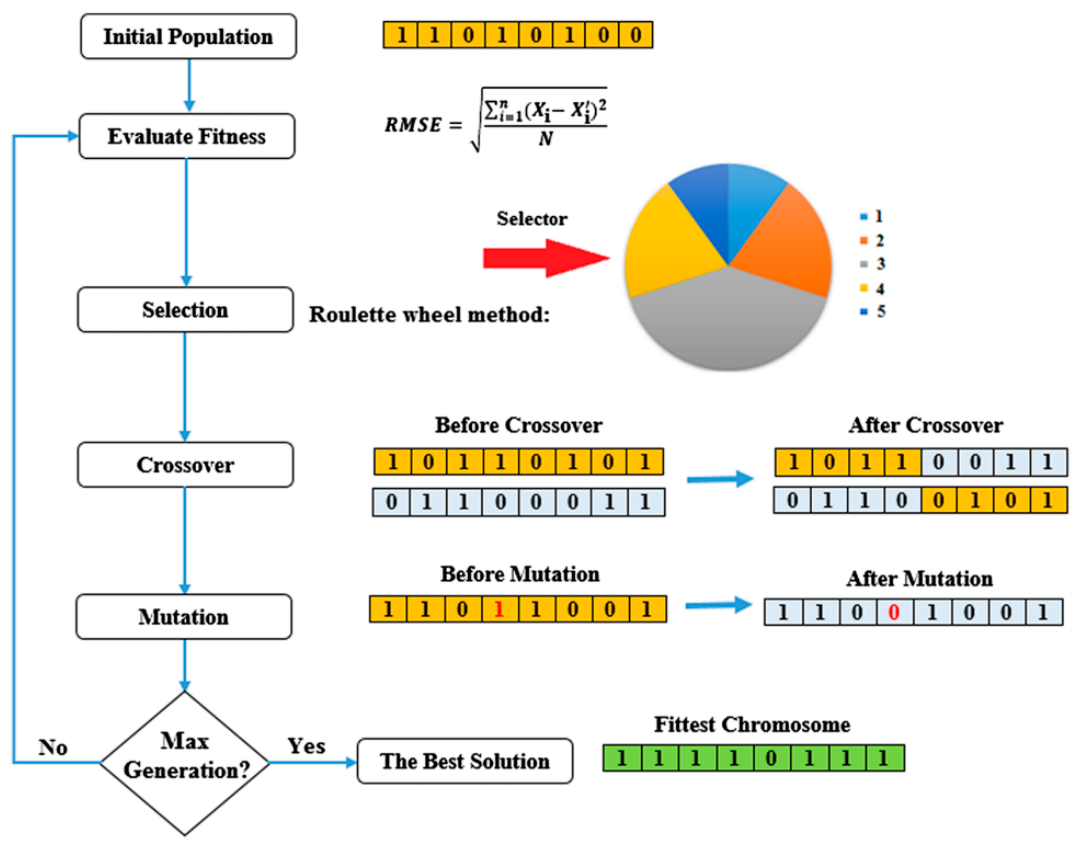
Figure 2. The main flowchart of the genetic algorithm (after Reference [39]).